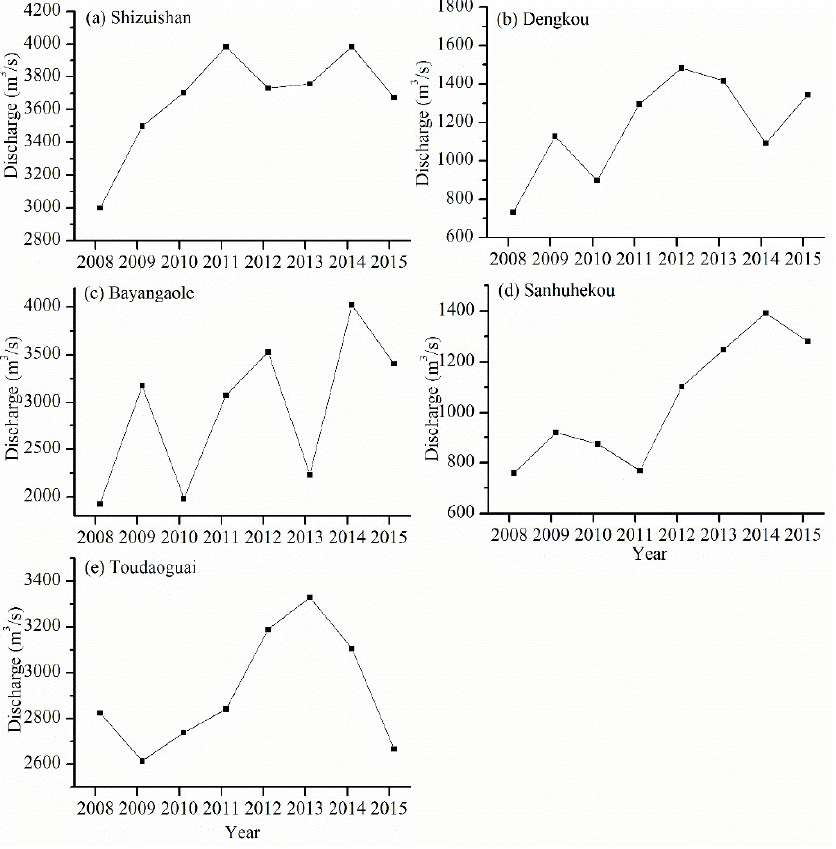
Figure 9. Variations of the discharging capacity of the cross-sections at the five gauging stations before each ice jam flooding season: ( a ) Shizuishan station; ( b ) Dengkou station; ( c ) Bayangaole station; ( d ) Sanhuhekou station; and ( e ) Toudaoguai station.